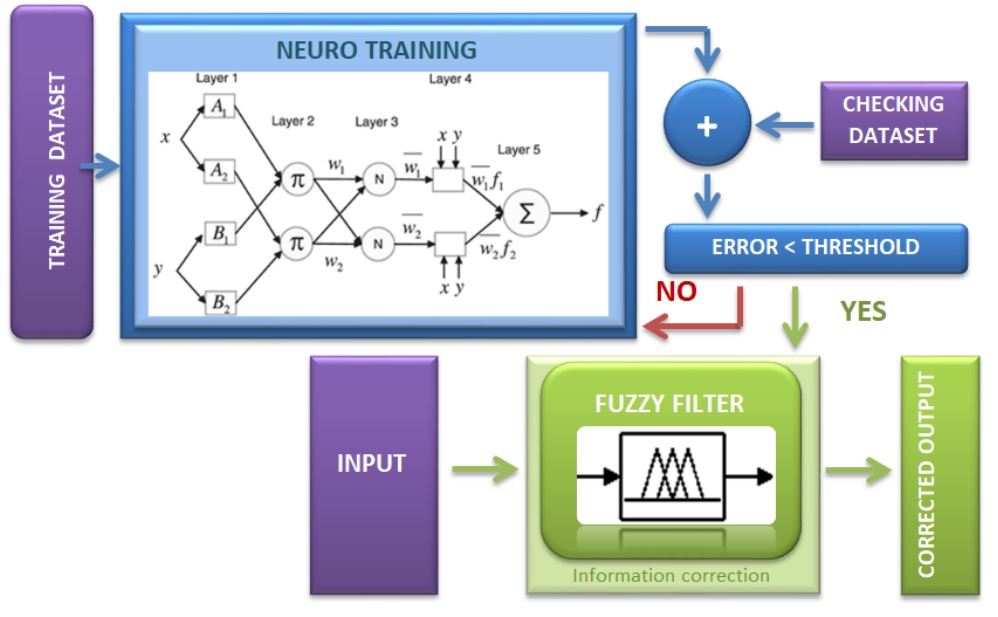
Figure 10. Adaptive Neuro-Fuzzy Inference System (ANFIS) network